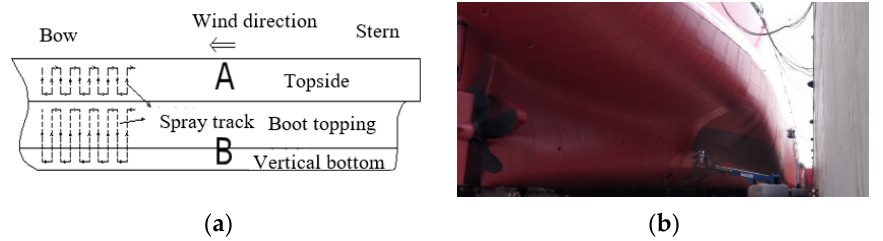
Figure 2. Manual painting track of ship’s outer plate in a shipyard dock in China. ( a ) Construction drawing; ( b ) Physical drawing